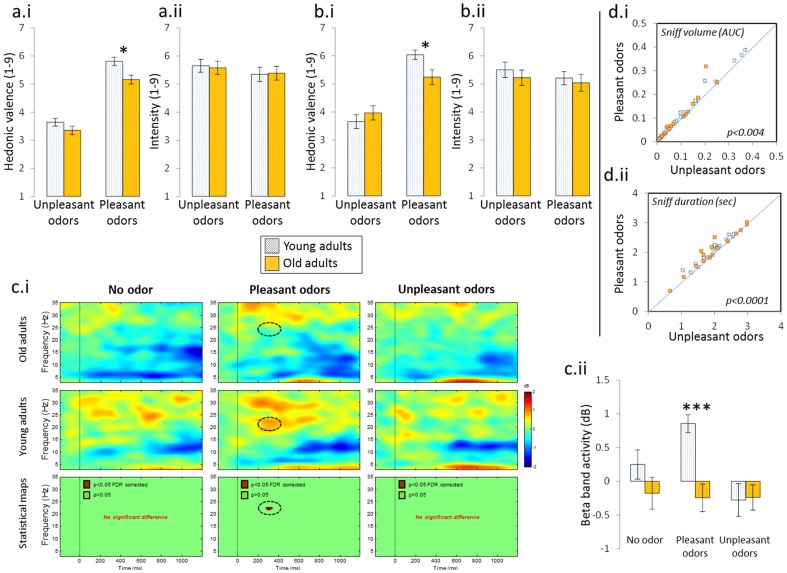
Effects of aging on hedonic appreciation and EEG responses to pleasant and unpleasant odors.(a) Experiment 1. Hedonic appreciation (a.i.) but not intensity ratings (a.ii.) of pleasant odors decreased in old adults. (b) Experiment 2 - psychophysics. Hedonic appreciation (b.i.) but not intensity ratings (b.ii.) of pleasant odors decreased in old adults. (c) Experiment 2 – OERSP. Time-frequency maps for the “no odor”, “pleasant odors” and “unpleasant odors” conditions in old adults and young adults, and corresponding statistical maps (c.i.). A significant difference between Old adults and Young adults was observed for pleasant odors, at the corrected statistical threshold of p<0.05 (FDR). Beta event-related synchronization decreased in old adults only for pleasant odors (c.ii.). (d) Experiment 2 – sniffing. Sniff volume (d.i.) and sniff duration (d.ii.) are significantly greater for pleasant odors than for unpleasant odors, both in young (white square) and old (orange square) adults. Error bars correspond to SEM. * = p<0.05, *** = p<0.0001.